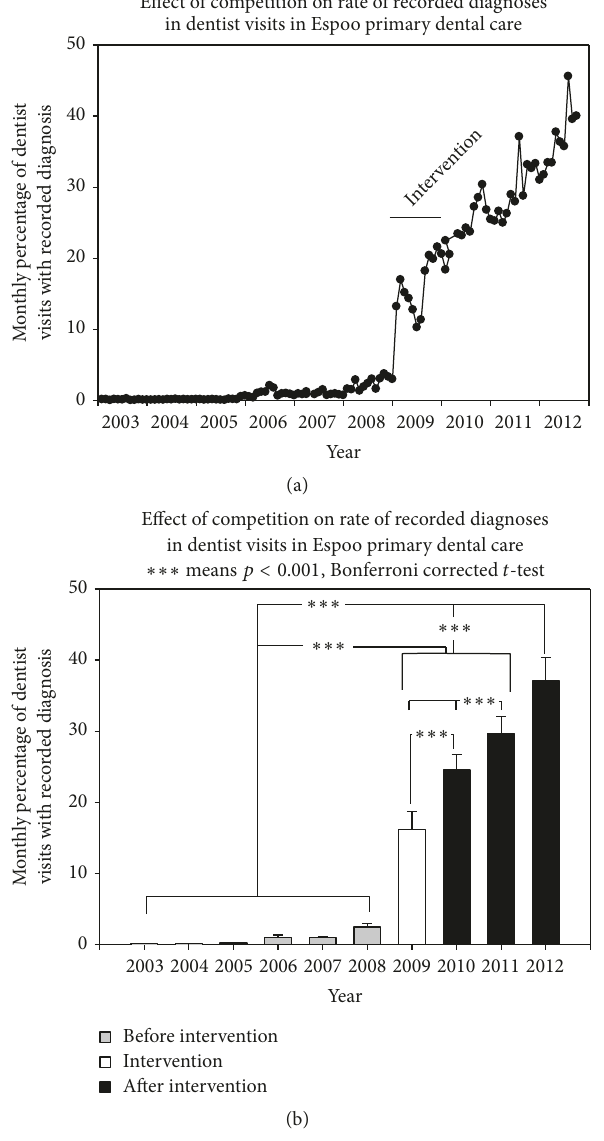
Figure 1: (a) Monthly percentage of dentists’ visits with recorded diagnoses before, during, and after the playful competition in 2009. (b) Year-based percentage of monthly dentists’ visits with recorded diagnoses during the same observation periods. Means (bars) and SDs (brackets) are presented.